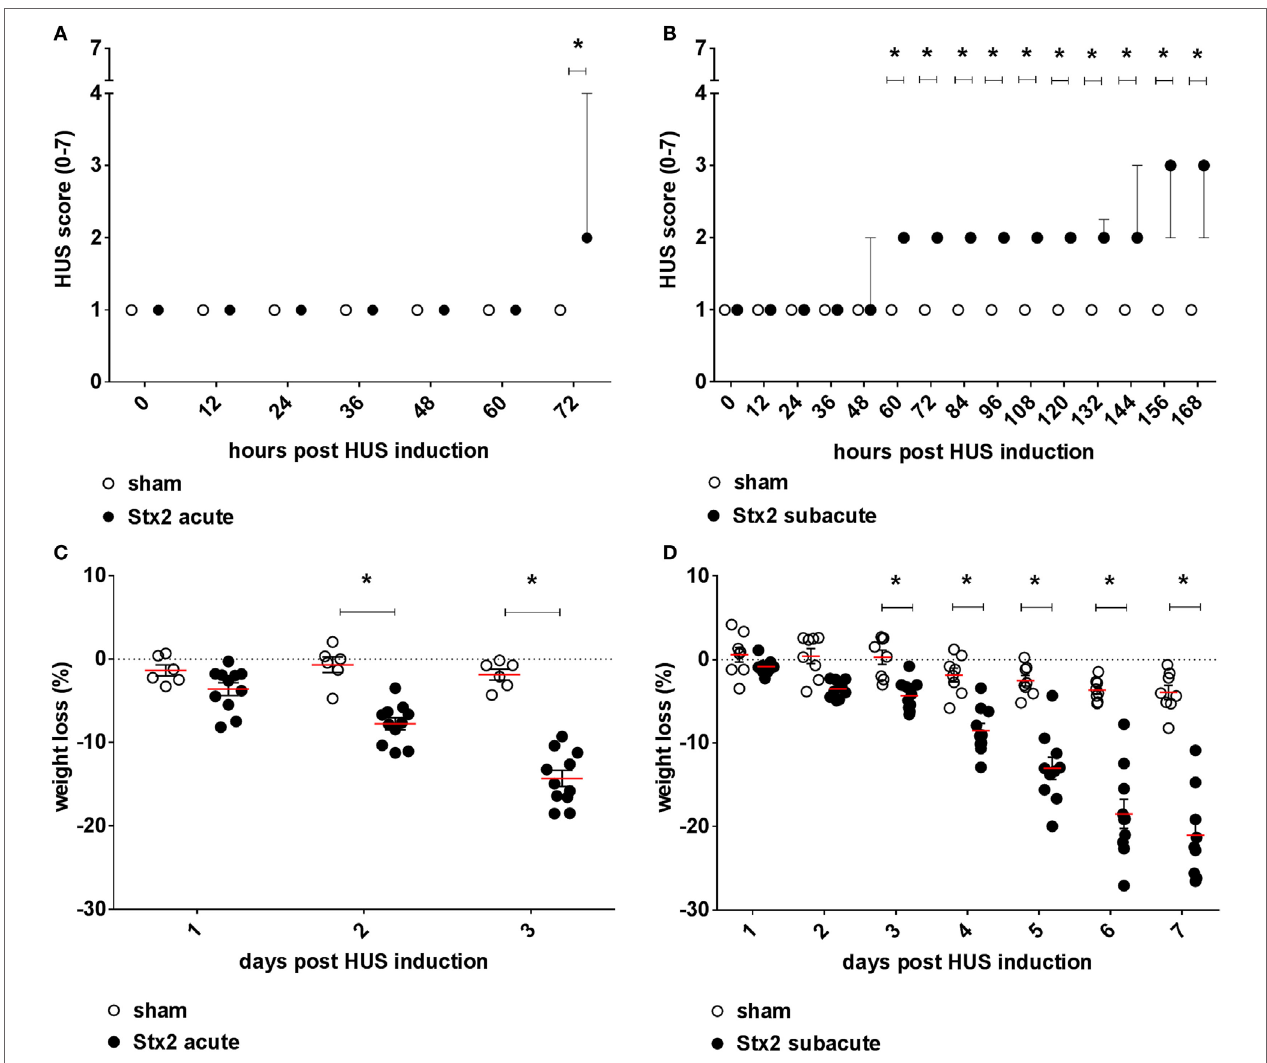
FigUre 2 | Clinical presentation of C57BL/6J mice subjected to different Stx2 regimens. Clinical presentation was assessed by a score ranging from 1 = very active to 7 = dead for the (a) acute model (sham n = 6, Stx2 n = 11) and (B) subacute model (sham n = 8, Stx2 n = 10). (a,B) Data are expressed as median ± interquartile range for n observations. * p < 0.05 for sham vs. Stx2 at each respective time point (Mann–Whitney U -test). Weight loss of C57BL/6J wild-type mice was assessed every 24 h for the (c) acute model (sham n = 6, Stx2 n = 11) and the (D) subacute model (sham n = 8, Stx2 n = 10). (c,D) Data are expressed as mean ± SD for n observations. * p < 0.05 for sham vs. Stx2 at each respective time point (two-way ANOVA with Bonferroni post hoc